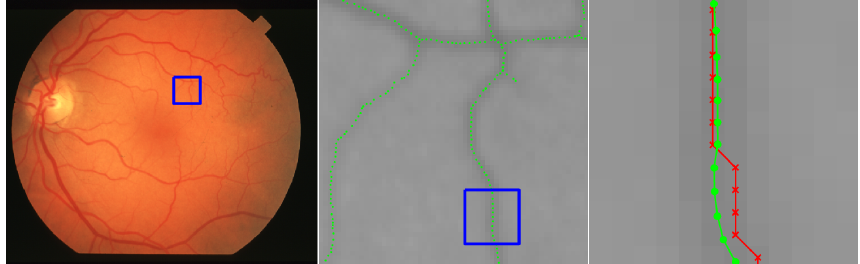
Figure 16. Image of a retinal scan for a healthy eye, where we seek to localize blood vessels. The red symbols denote pixel-level streak estimates and green dots denote the refined subpixel localization estimates. The original image is im00032 from the STARE database [32,33].